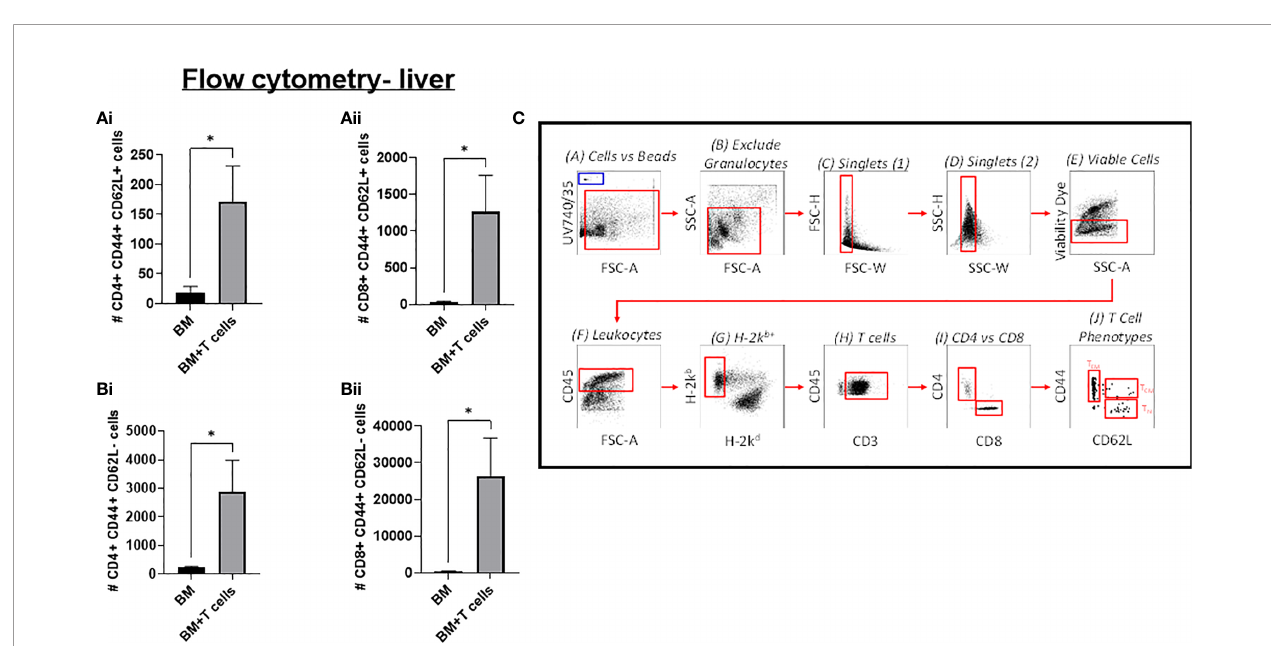
FIGURE 3 | Signi fi cant increases in T-cells in the liver at day 6 post-GvHD- Flow cytometry analysis shows signi fi cant increases in effector and central memory T-cells (A) (i) CD4+ and (ii) CD8+ TEM (CD44+ CD62L+) and (B) (i) CD4+ and (ii) CD8+ TCM (CD44+ CD62L-)cells in the liver con fi rms the onset and progression GvHD in mice transplanted with BM+T-cells. (C) Gating strategy for fl ow cytometry analysis. Data is Mean ± SEM. n=9. *=p < 0.05 unpaired Students